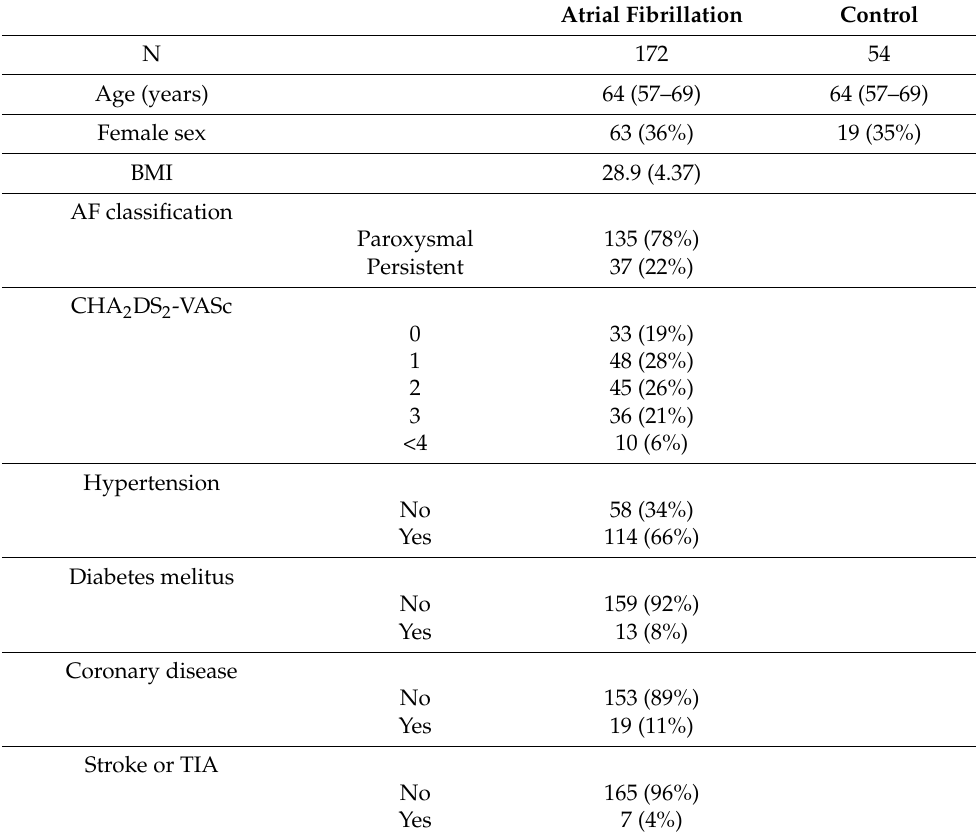
Table 1. Study population